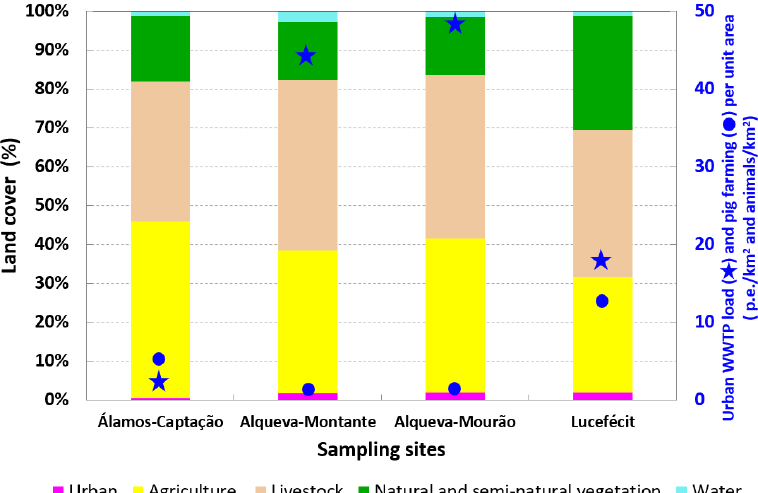
Figure 3. Percentages of the land use classes in the drainage basins of the sampling locations at Alqueva reservoir. Blue stars indicate the total urban wastewater treatment plants’ (WWTP) load and blue circles illustrate the number of animals, both per unit area at each drainage basin.